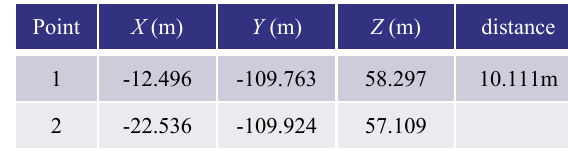
Table 6. Distance measurement by TLS